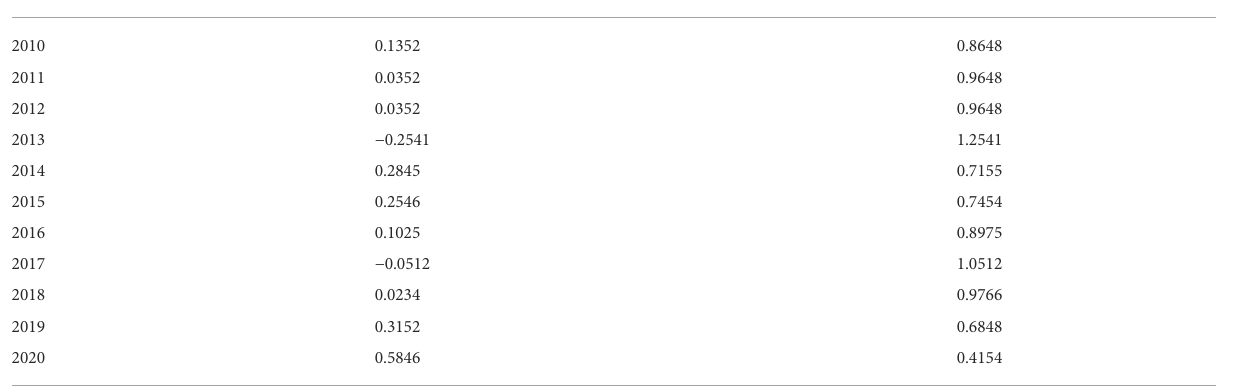
TABLE 3 Stationarity test